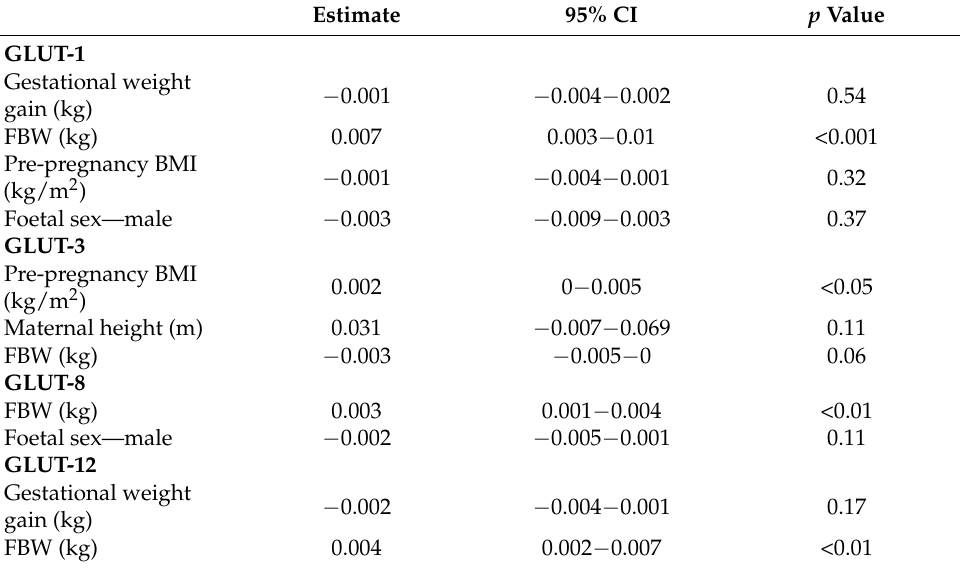
Table 4. Factors contributing to glucose transporter expression—results of the linear multivariate regression analysis. Estimate 95% CI p